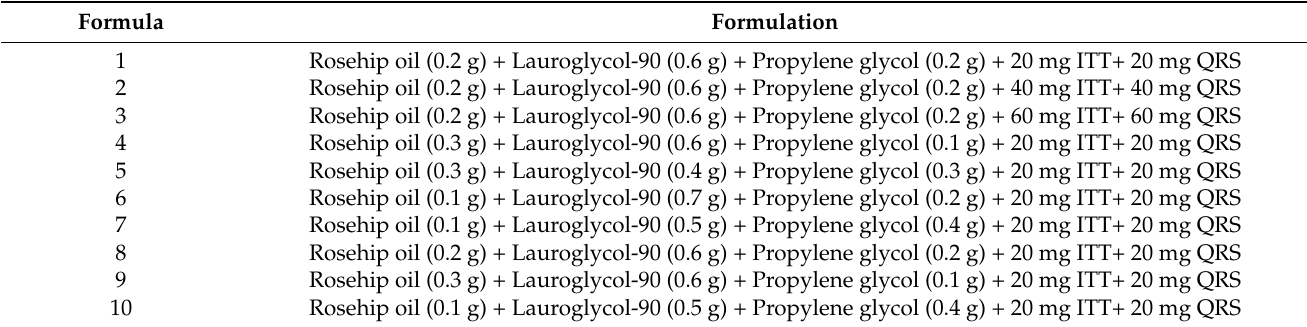
Table 1. Preliminary formulation prepared to study the emulsification of isotretinoin (ITT) and quercetin (QRS). Formula